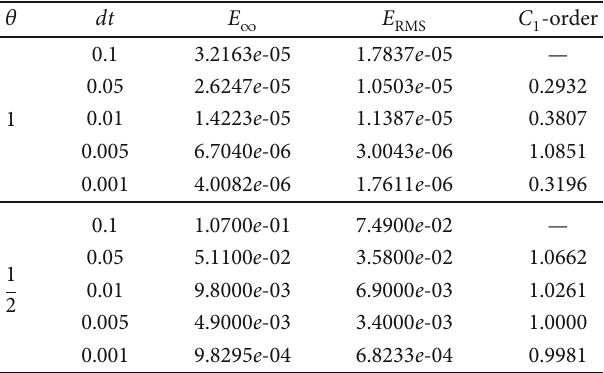
Table 1: Error norms and computational order for di ff erent values of dt with c = 5 : 1, N = 50 for the Problem 3.